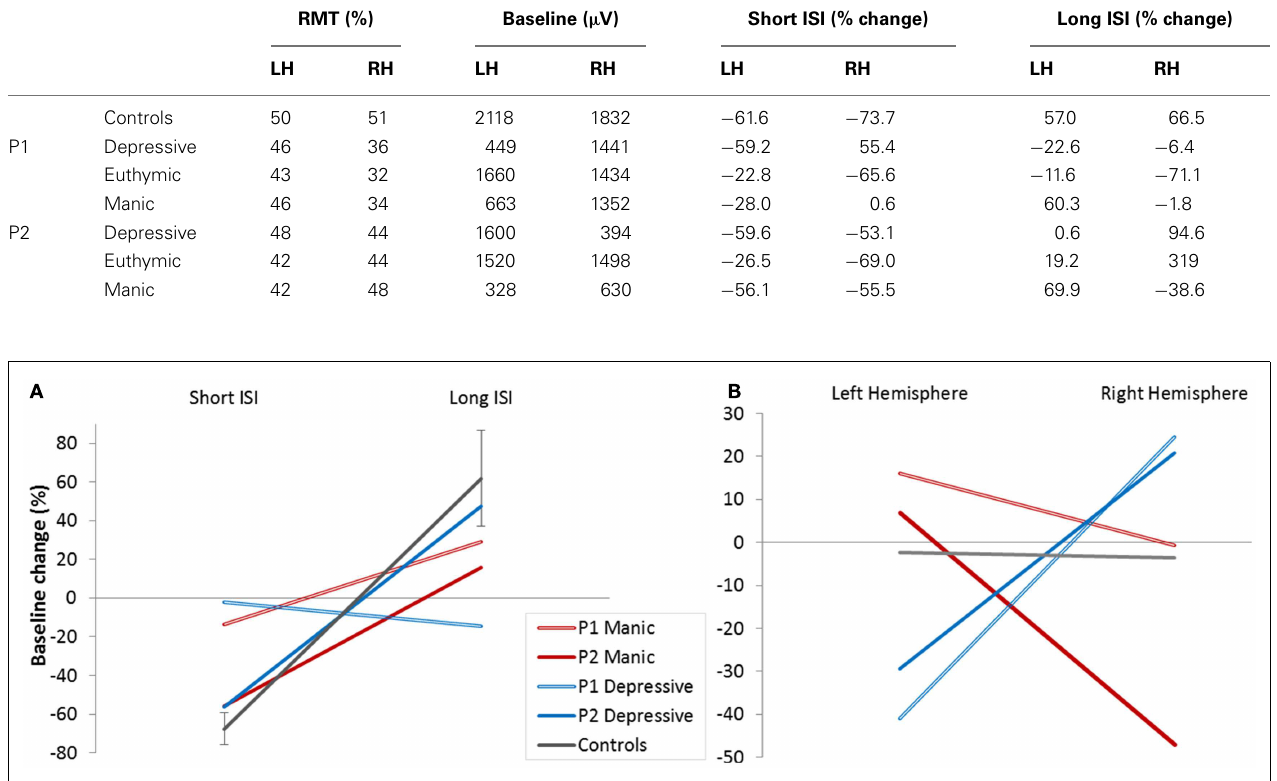
FIGURE 3 | Cortical excitability. (A) Baseline modifications (%) in controls and patients (depressive/manic) according to Inter Stimulus Intervals (ISI short/long). (B) Baseline modifications (%) in controls and patients (depressive/manic) according to stimulated